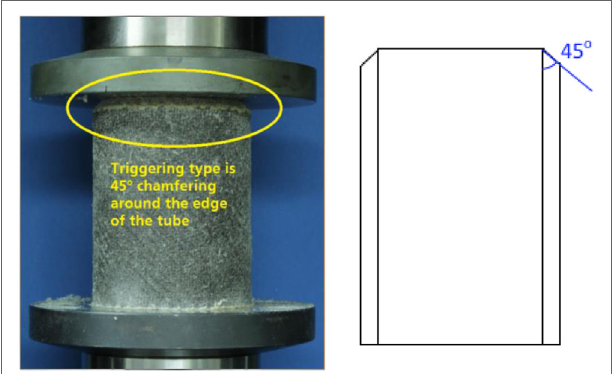
FigUre 1 | The type of triggering used for the energy absorption tubes.